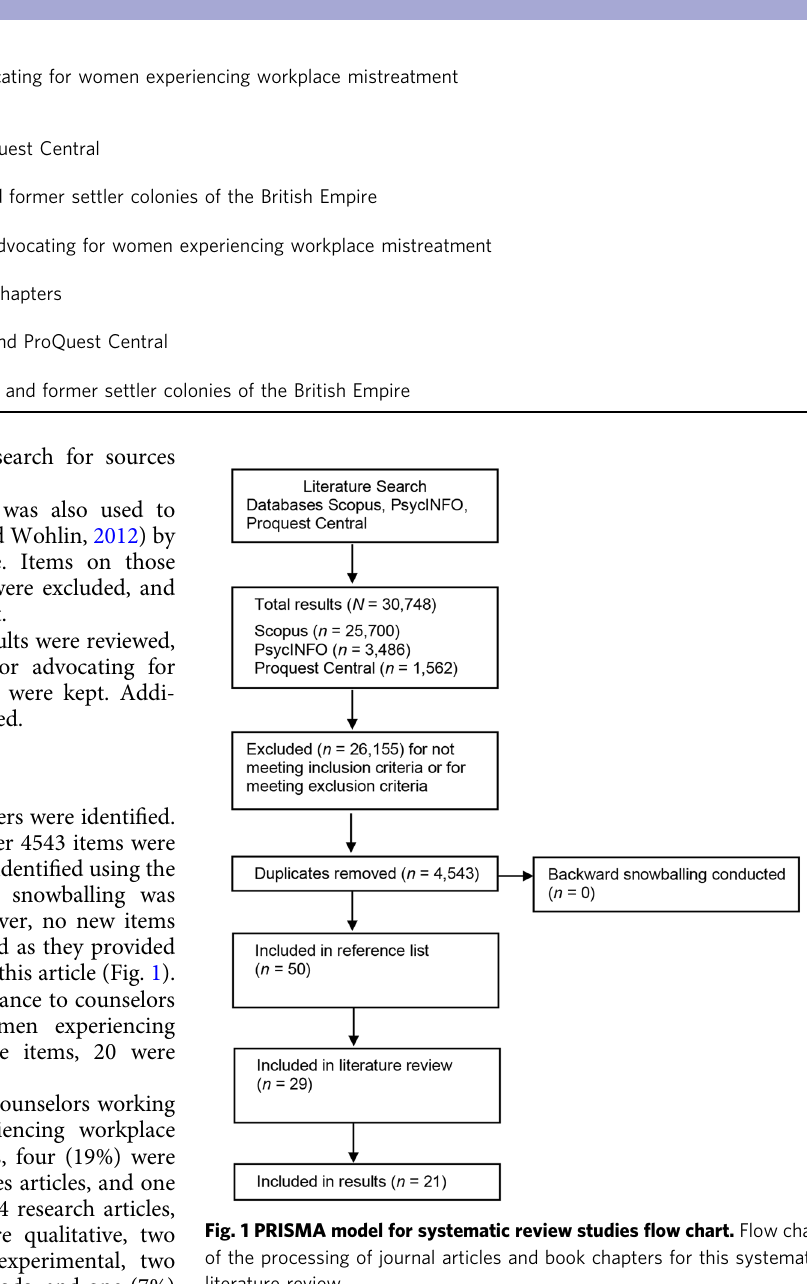
Table 1 Inclusion and exclusion criteria.